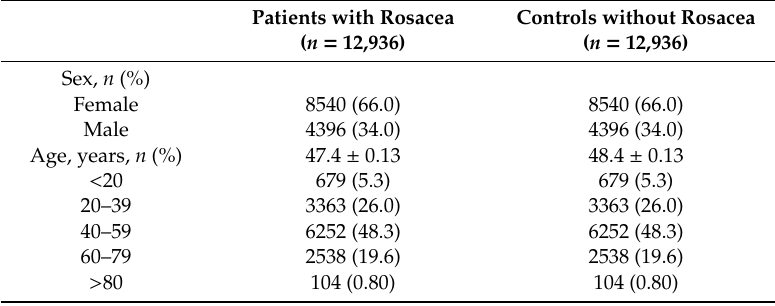
Table 1. Characteristics of the study